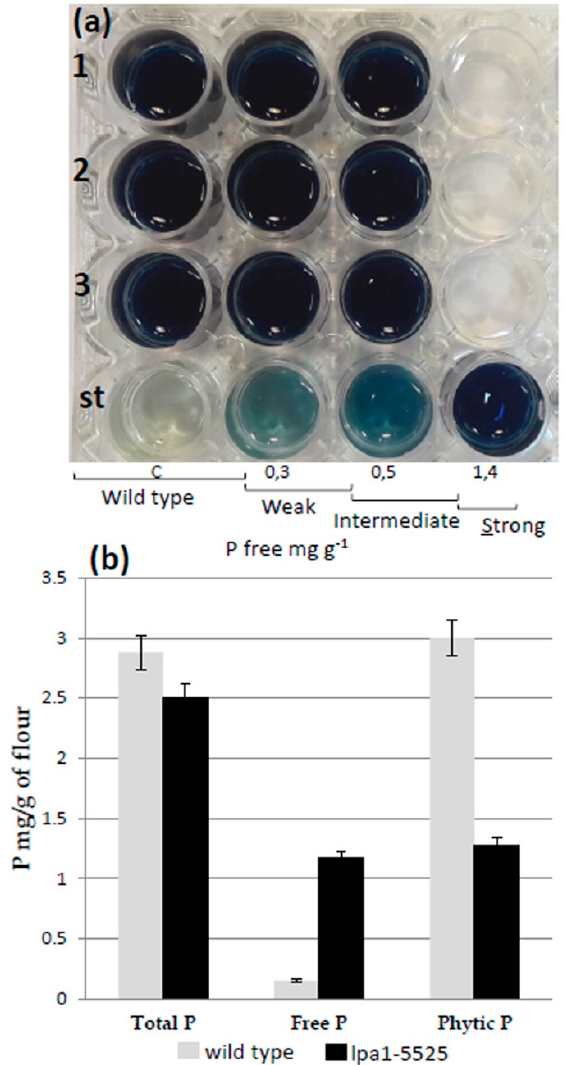
Figure 4. ( a ) Chen assay performed on F4 families mutant seeds. Microtiter rows 1, 2 and 3 show the results of the assay performed on nine mutant seeds, st row correspond to the standard used for the semiquantitative classification. ( b ) lpa1-5525 mutant and wild type control mature dry kernels were analyzed for total P, free inorganic P and phytic acid P amount. Values are expressed as milligrams of P (atomic weight 31) in 1 g of flour. Confidence intervals at 95% are shown.